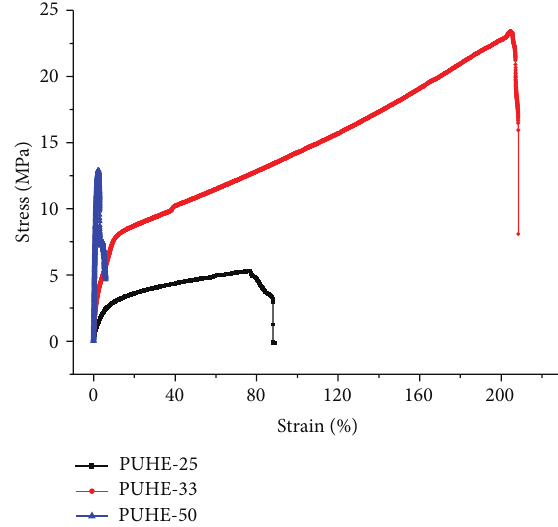
Figure 5: TGA curves of PHB-diol (a) and PUHE (b).